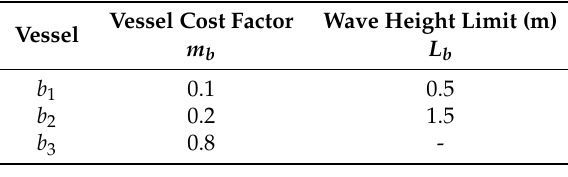
Table 3. Vessel cost and transportation limit.